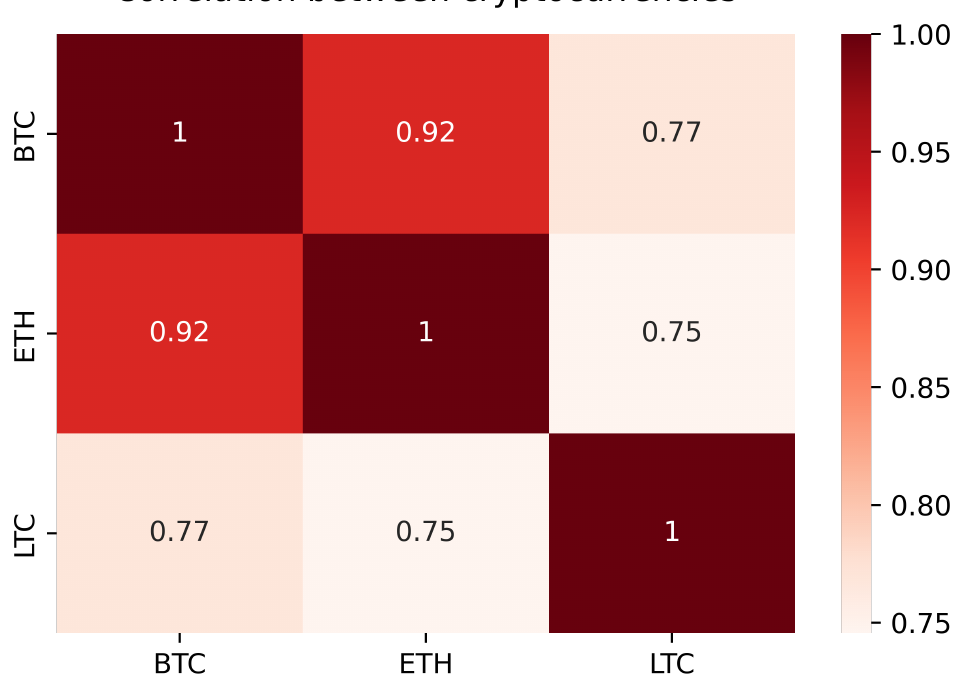
Figure 7. Heat map representing the correlation for BTC, ETH, and